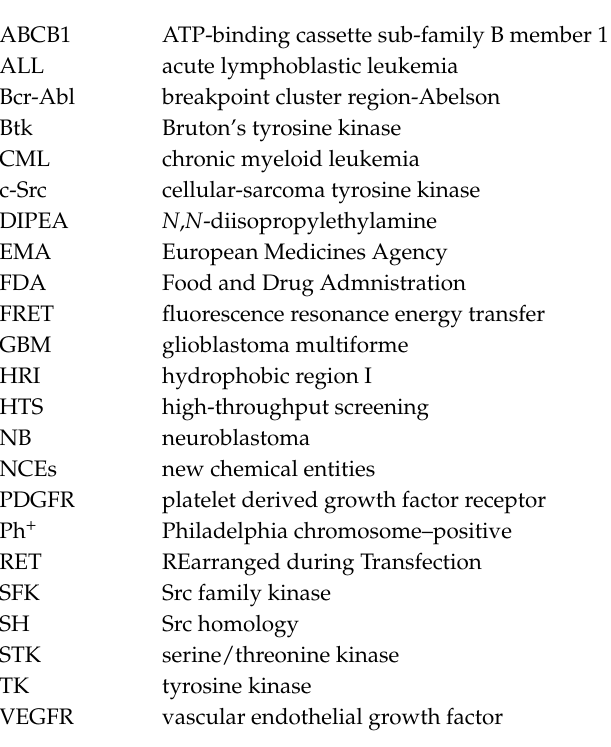
Supplementary Materials: The following are available online. Figure S1: Antiproliferative effect of selected compounds evaluated by in vitro analysis of percentage of viable cells respect untreated cells (100%) after 72 h of incubation. Compounds were used for treating neuroblastoma cells (upper panel) and glioblastoma cells (bottom